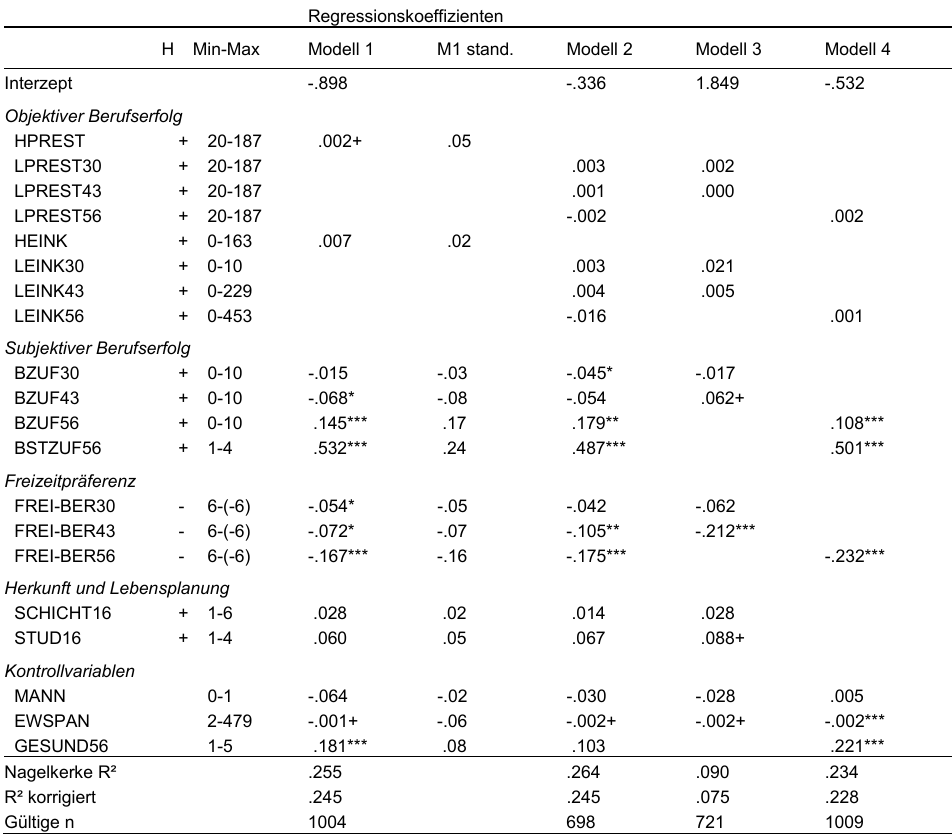
Tabelle 4 : Lineare Regression von B-WICHTIG auf Berufserfolg und Freizeitpräferenz, soziale Herkunft und Lebensplanung sowie